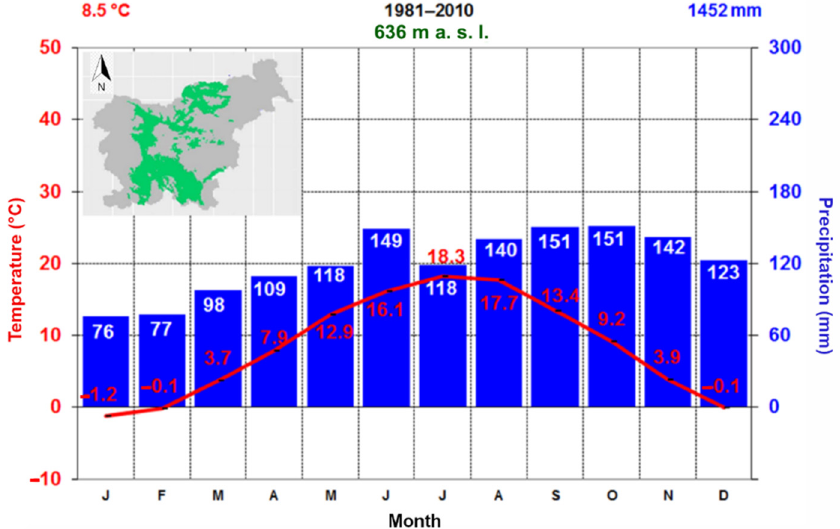
Figure 1. Climograph of the moderate climate of hilly region, climate type at Farm1e and Farm1i (Reprinted with permission from Ref. [22]. Copyright 2016, Katja Kozjek). Numbers in upper corners represent average annual temperature ( left ) and precipitation ( right ).